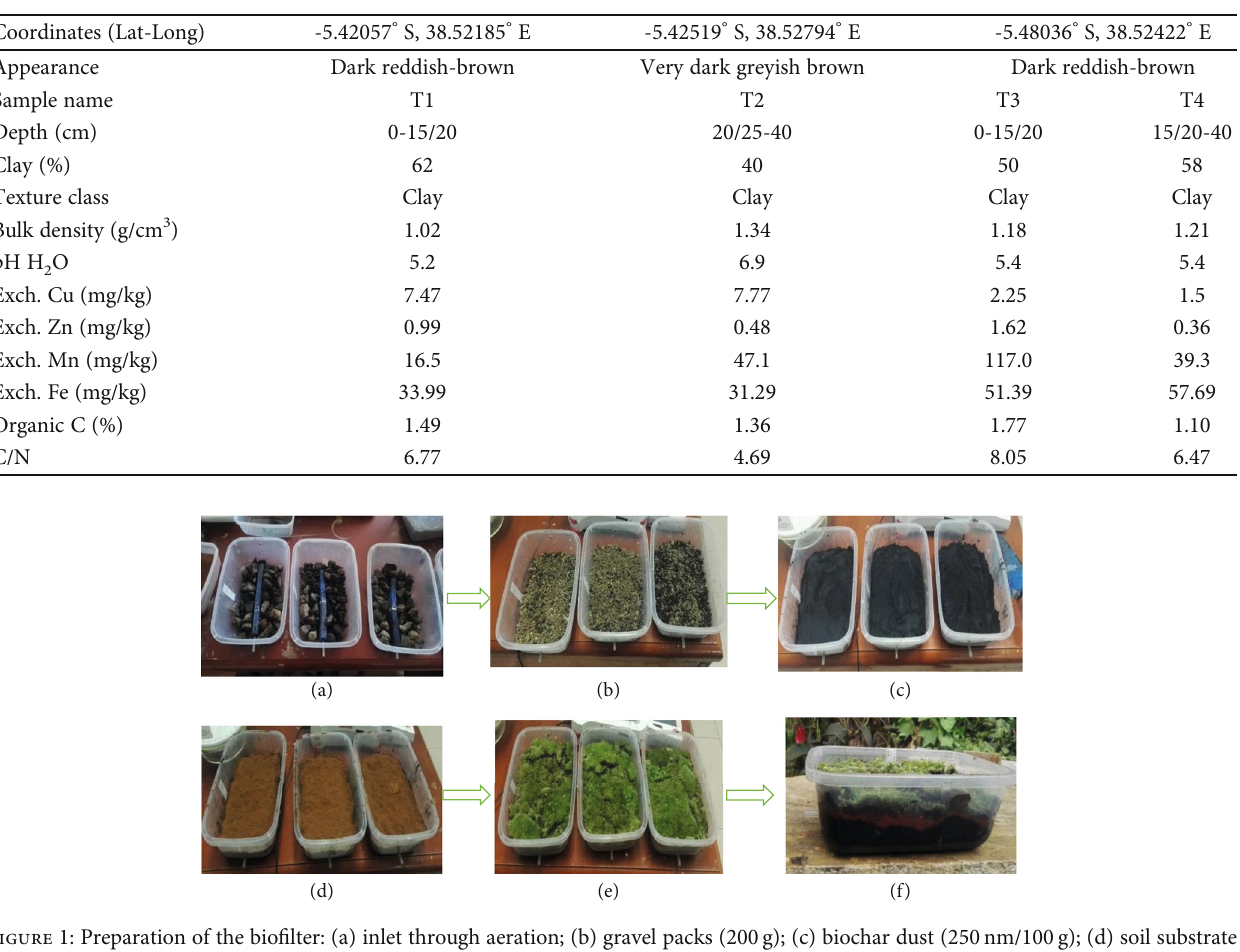
Table 1: Soil database and pro fi le information.